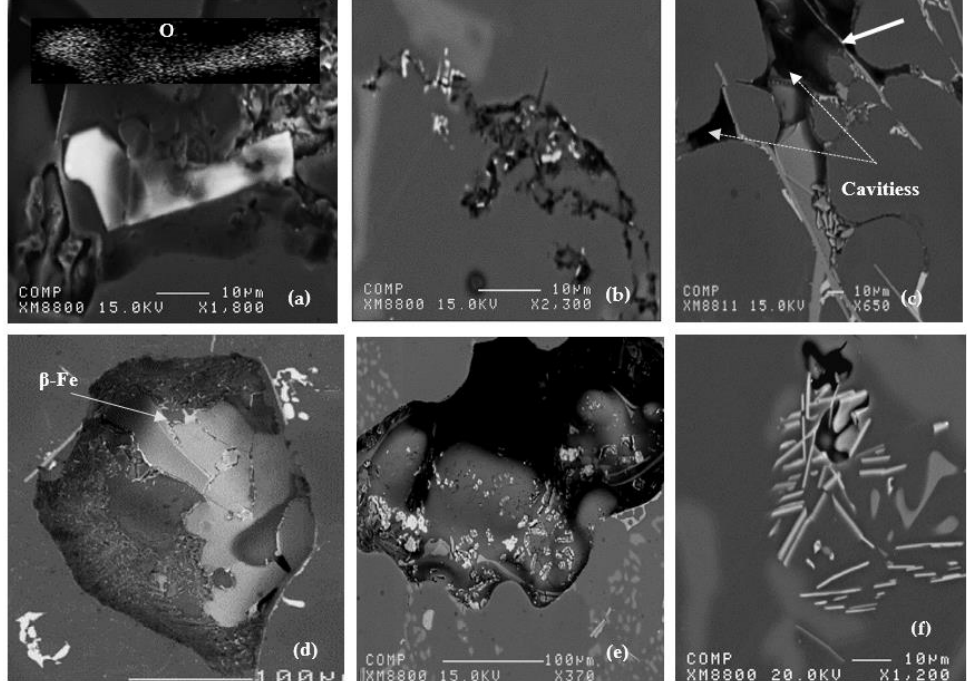
Figure 9. Examples of porosity formed in samples obtained from non-degassed melts related to ( a ) Al 2 SrO 3 platelet, ( b ) oxide films, ( c ) intermetallics-white arrow, ( d ) gas porosity, ( e ) shrinkage porosity, ( f ) microporosity (large 15 °− 11.5 cm casting samples).